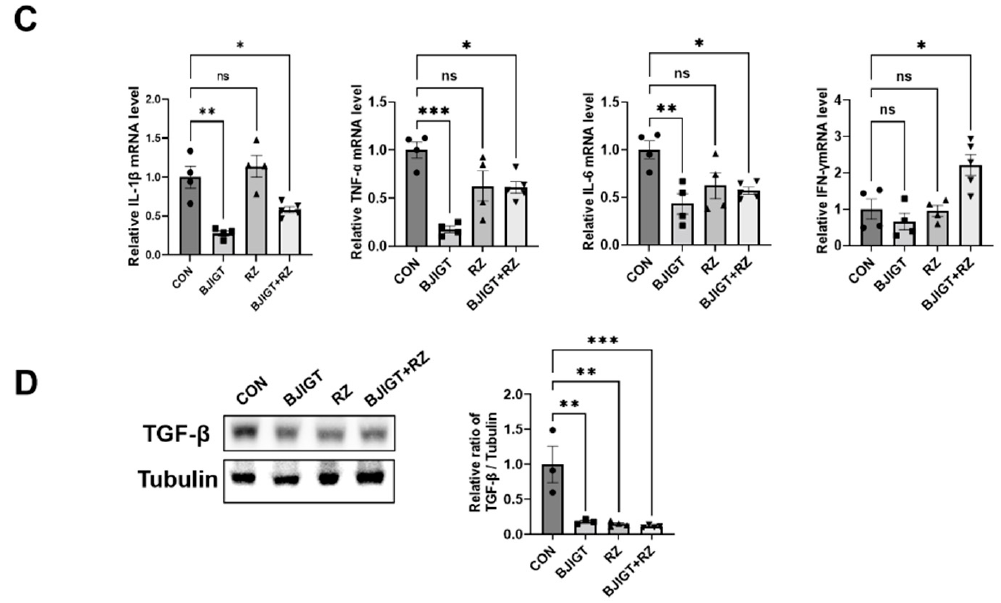
Figure 5. Combined BJIGT/RZ treatment protects motor neurons and reduces neuroinflammation in the spinal cord (SP) of the hSOD1 G93A ALS mouse model. ( A ) Photomicroscopic images of Nissl staining and immunostaining of choline acetyl transferase (ChAT), ionized calcium-binding adaptor molecule 1 (Iba-1), and glial fibrillary acid protein (GFAP) in the SP of each group of hSOD1 G93A ALS mice. ( B ) Quantification of the number of Nissl-stained motor neurons and ChAT-positive neurons (maker for cholinergic neuron), and the intensity of Iba-1 positive cells (marker for microglial cells) and GFAP-positive cells (marker for astrocytes) ( n = 4–5/group) (scale bar, original magnification ×200; bar represents 200 μ m). ( C ) Quantitative analysis of the relative mRNA expression of the proinflammatory cytokines interleukin 1 β ( IL-1 β ), tumor necrosis factor α ( TNF- α ), IL-6 , and interferon γ ( IFN- γ ) in the GC of each group of hSOD1 G93A mice ( n = 4–5/group). ( D ) Representative immunoblots and quantification of the bands pertaining to transforming growth factor β (TGF- β ) in the GC of each group of hSOD1 G93A mice. Tubulin was used as the loading control. Data are normalized to the control group data and presented as mean ± SEM. ns: not significant, * p < 0.05, ** p < 0.01, and *** p < 0.001, compared with the control group. Distilled water (DW)-administered transgenic (Tg) mice (CON), BJIGT-treated Tg mice (BJIGT), RZ-treated Tg mice (RZ), and combined BJIGT/ RZ-treated Tg mice (BJIGT+RZ). The different number of circles, squares and triangles are indicated the number of sample sot.